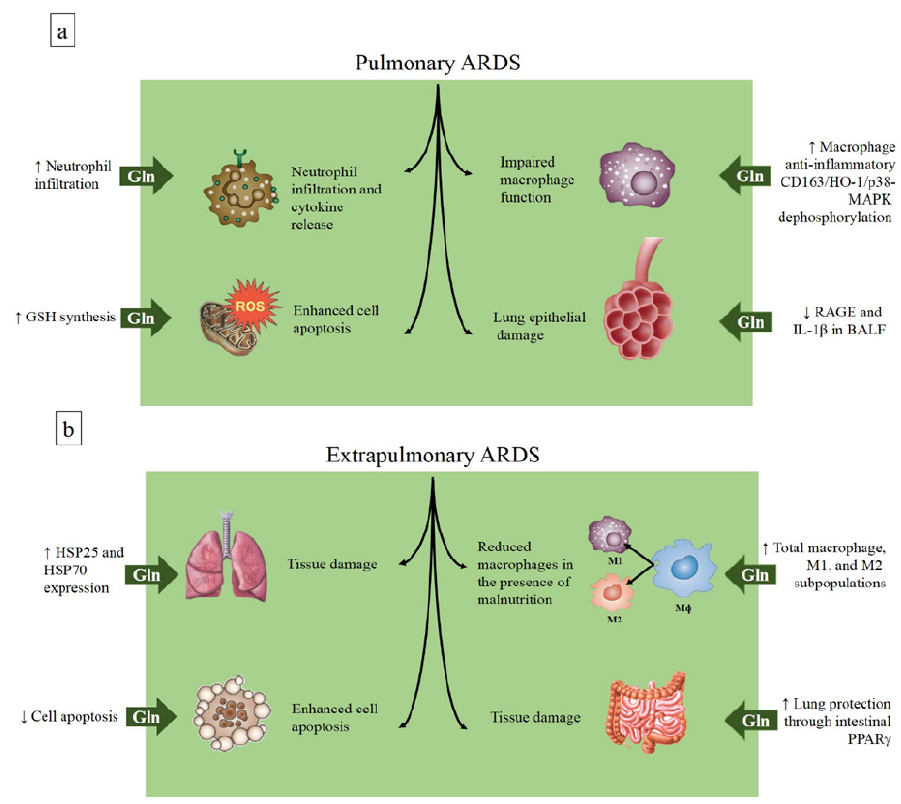
Figure 1. Effects of glutamine in models of pulmonary ( a ) and extrapulmonary ( b ) acute respiratory distress syndrome. ARDS, acute respiratory distress syndrome; BALF, bronchoalveolar lavage fluid; CD163/HO ‐ 1/p38 ‐ MAPK, CD163/heme ‐ oxygenase ‐ 1/p38 ‐ mitogen ‐ activated protein kinase; Gln, glutamine; GSH, reduced glutathione; HSP, heat shock protein; IL, interleukin; PPAR, peroxisome proliferator ‐ activated receptor; ROS, reactive oxygen species; M, macrophage; RAGE, receptor for advanced glycation end ‐ products; ROS, reactive oxygen species.